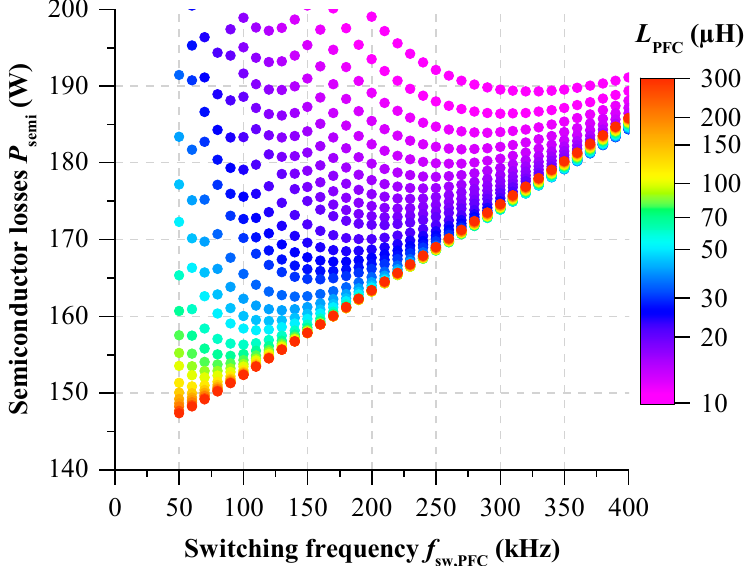
Figure 4. Semiconductor losses of V IENNA topology for SiC MOSFETs with 65 m Ω on-state resistance depending on switching frequency and PFC inductance.